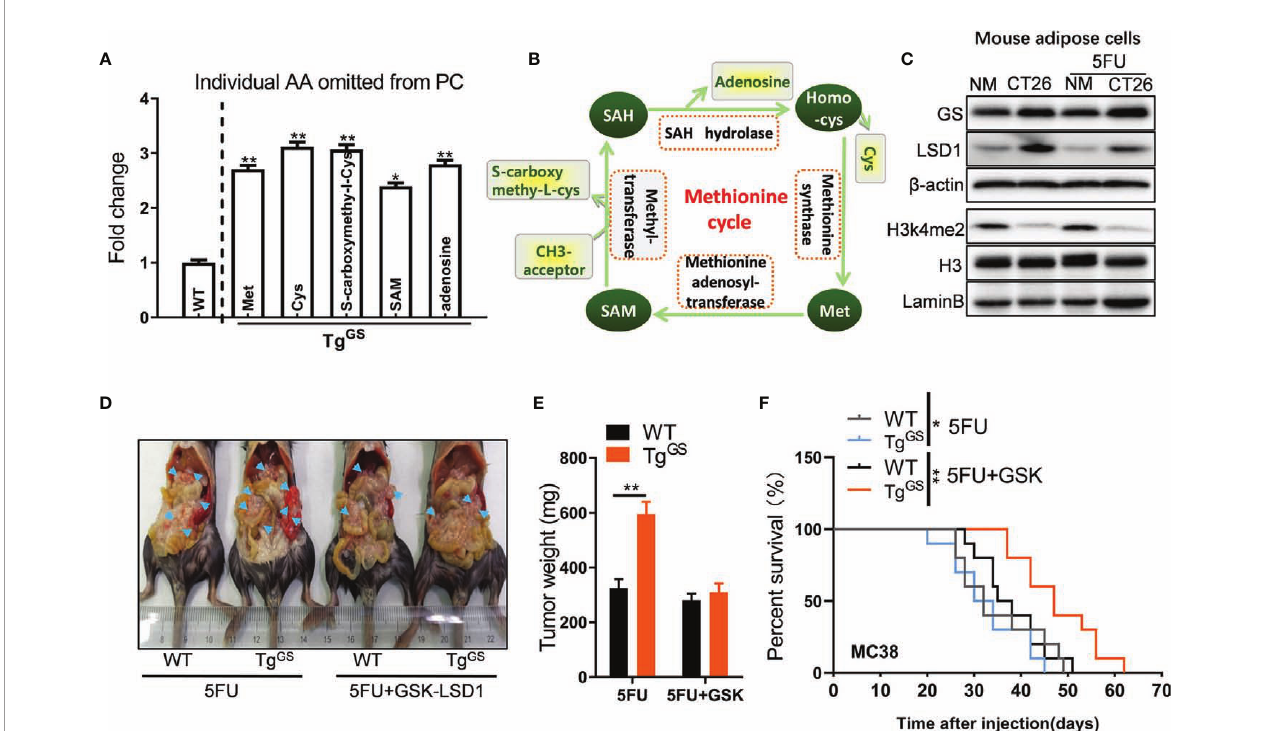
FIGURE 4 | Loss of H3K4me2 increases GS expression in adipose cells. (A) Fold change of individual amino acid (AA) omitted from PC of WT and Tg GS mice (n = 3, * P < 0.05, ** P < 0.01). (B) Schematic diagram of methionine cycle. (C) The protein levels of GS, LSD1, H3K4me2, and H3 in non-treated or 5FU-treated mouse adipose cells cultured with NM or CT26 cell supernatants were measured with Western blot. (D) WT mice and Tg GS mice were intraperitoneally inoculated with MC38 cells and treated with 5FU or 5FU+GSK-LSD1 for 2 weeks, respectively. Then, the representative images of the mic-bearing tumors were showed. Arrow heads, tumors. (E) The tumors in (D) were isolated and weighed (n = 5, ** P < 0.01). (F) Kaplan-Meier curves for the survival of 5FU-treated or 5FU+GSK-LSD1- treated WT mice or TG GS mice after MC38 tumor cell inoculation plotted against time (days after injection) (n = 10, ** P <